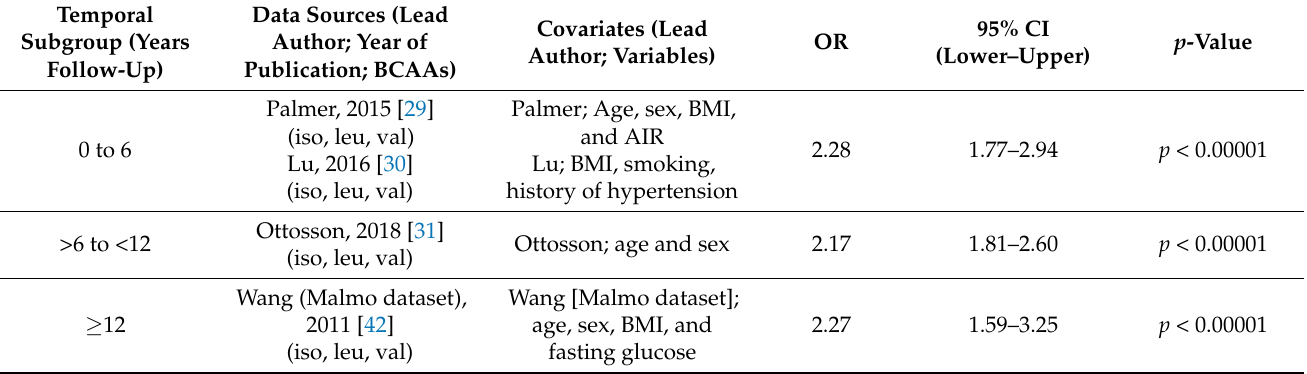
Table 3. Sensitivity analysis of all available datapoints, per temporal subgroup, where model adjustment with less than five covariates was undertaken by the publishing